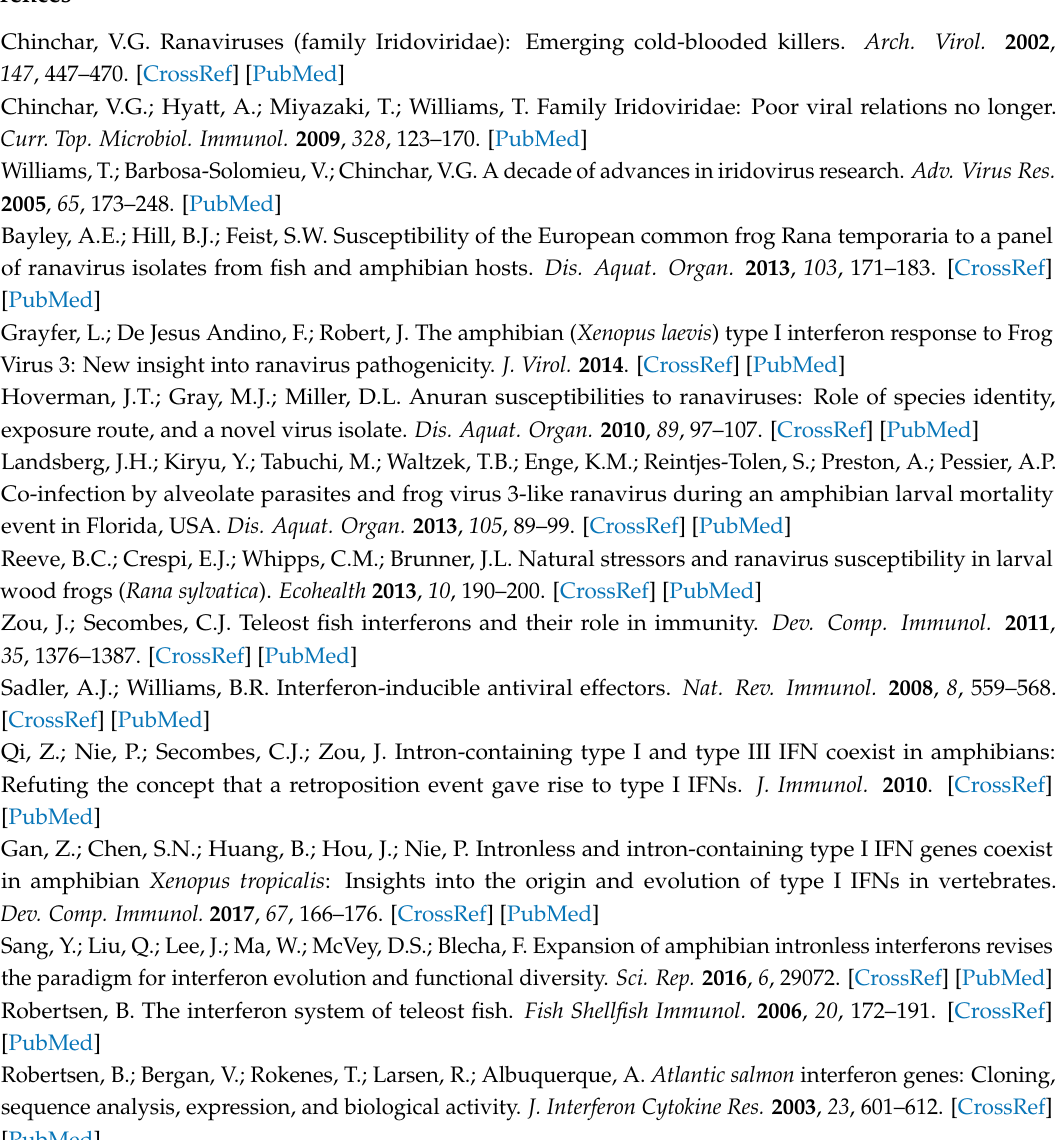
Figure S1: The phylogenetic tree was constructed using the neighbor joining method and bootstrapped 10,000 times (denoted as %s). The X. laevis IFNs chosen for gene expression analyses are indicated by